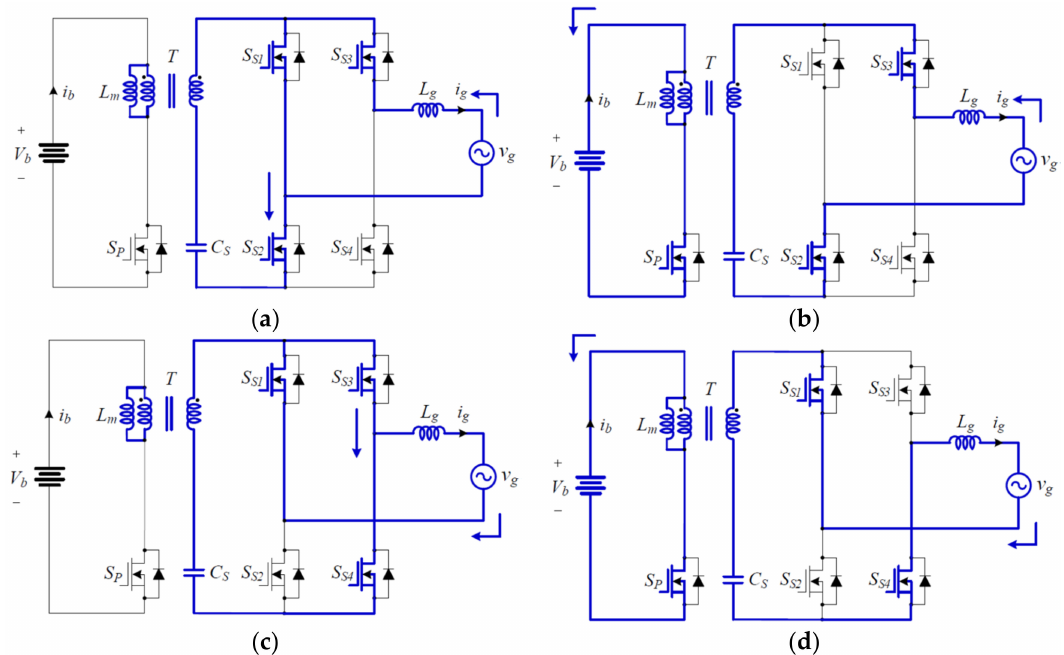
Figure 3. Switching states in the rectifier mode: ( a ) state 1 for the positive grid voltage; ( b ) state 2 for the positive grid voltage; ( c ) state 3 for the negative grid voltage; ( d ) state 4 for the negative grid